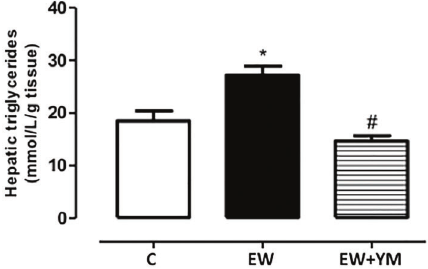
Figure 7. Yerba mate treatment prevented liver fat accumulation induced by early weaning. A , Photomicrographs of liver tissue stained with hematoxylin-eosin with same magni fi cation (magni- fi cation 60 (cid:1) ; bar: 30 m m). B , percentage steatosis at postnatal day 180 of adult rats that were normally breastfed for 21 days (C), early weaned (EW), or EW that received yerba mate for 30 days (EW + YM). The arrows indicate the droplets of lipids in the hepatocytes characterizing a microsteatosis. Data are reported as means ± SE of 5 rats per group. *P o 0.05 vs C; # P o 0.05 vs EW (ANOVA and Newman-Keuls multiple comparison